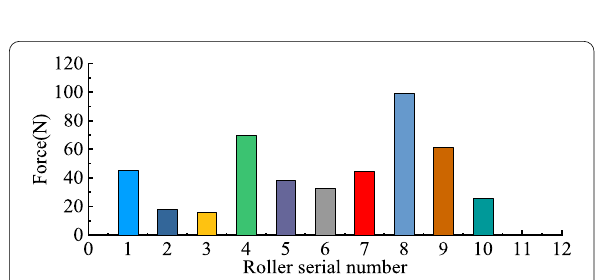
Figure 31 Collision force between roller and cam ring at F